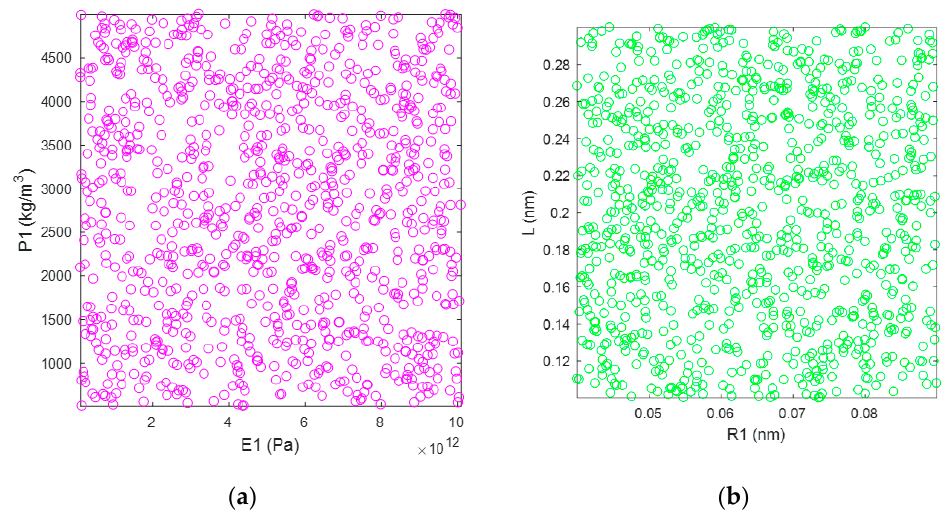
Figure 3. The stochastic samples of corresponding parameters in the finite plane element model of graphene based on Monte Carlo simulation. ( a ) are for the material parameters E1 and P1, ( b ) are for the geometrical parameters R1 and L, respectively.